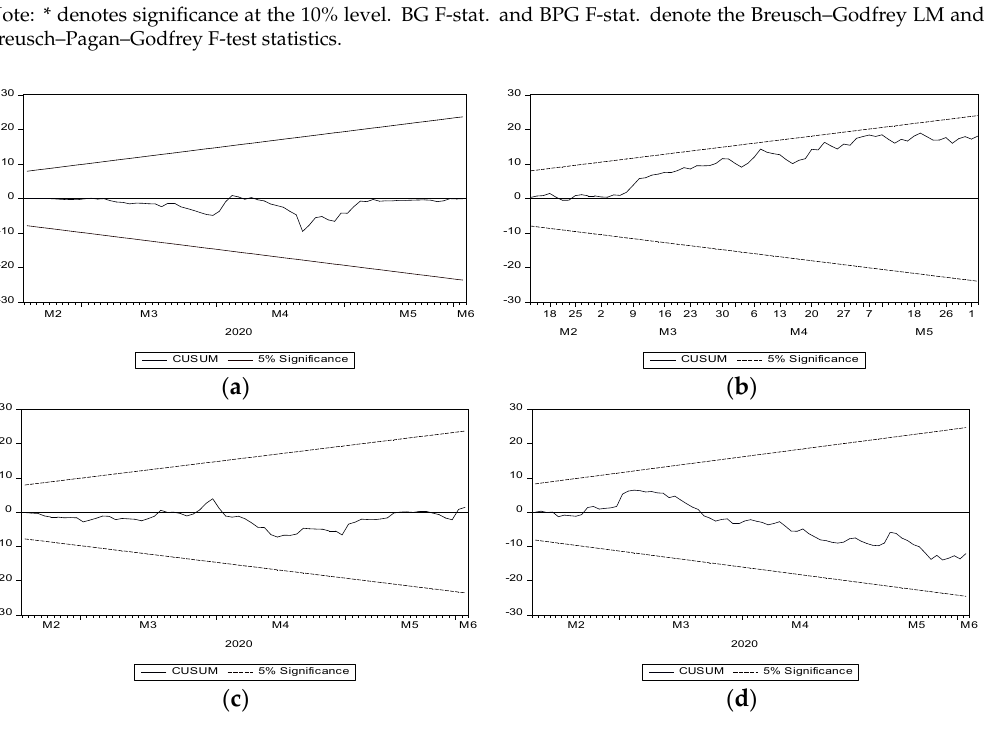
Figure 6. The CUSUM test, ( a ) WTI vs. COVID US, ( b ) HH vs. COVID US, ( c ) Dubai vs. COVID JP, ( d ) JKM vs. COVID JP.